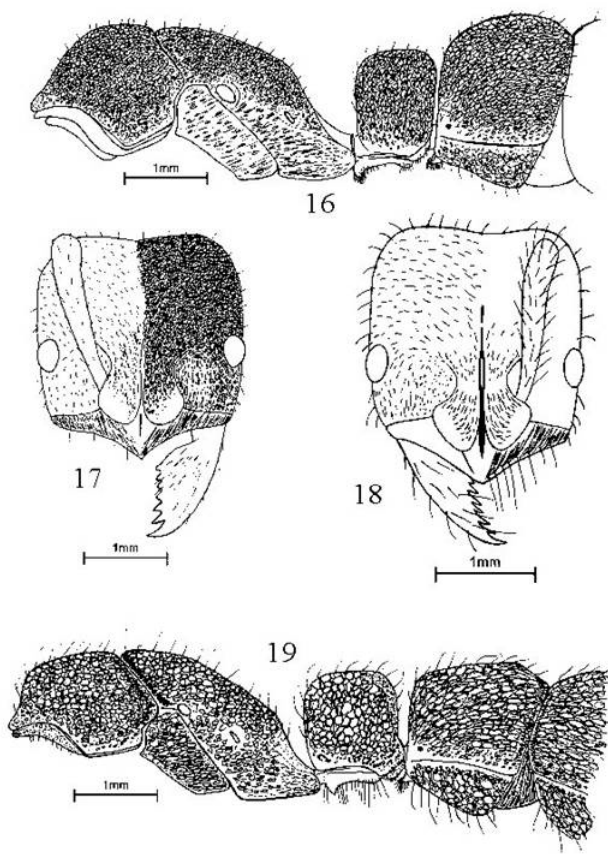
Fig 16 . The lateral view of the lectotype worker of B. montivaga (Iziko). Fig 17 . The head of the lectotype worker of B. montivaga (Iziko). Fig 18 . The head of the holotype worker of B. pumicosa (Iziko). Fig 19 . The lateral view of the holotype worker of B. pumicosa